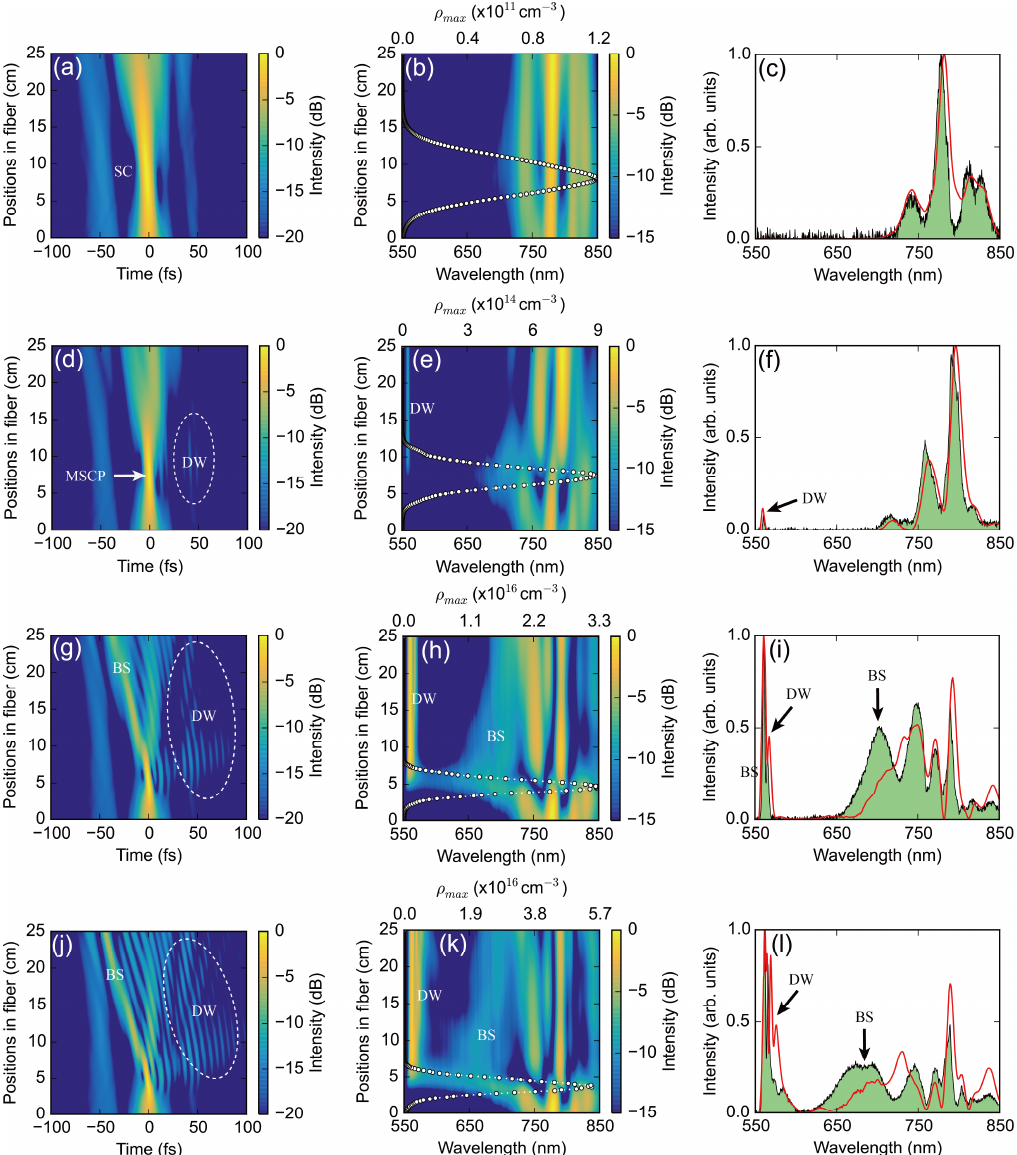
Figure 4. Plotted using the open source software Python(x,y). Simulated temporal ( a , d , g , j ) and spectral ( b , e , h , k ) evolutions in a 25-cm-long Ar-filled SR-PCF with 24-µm core diameter and 1.4-bar gas pressure at different input energies. ( a – l ) correspond to input pulse energies of 0.5 µJ, 1.1 µJ, 2.0 µJ and 2.6 µJ, respectively. The measured (green shaded region) and simulated (red solid line) normalized spectral intensities for different input energies at the output of the SR HC-PCF are shown in ( c , f , i , l ). The white circle lines in panels ( b , e , h , k ) point out the maximum plasma density. In ( a ), SC = soliton compression, in ( d ), MSCP = maximum soliton compression point.